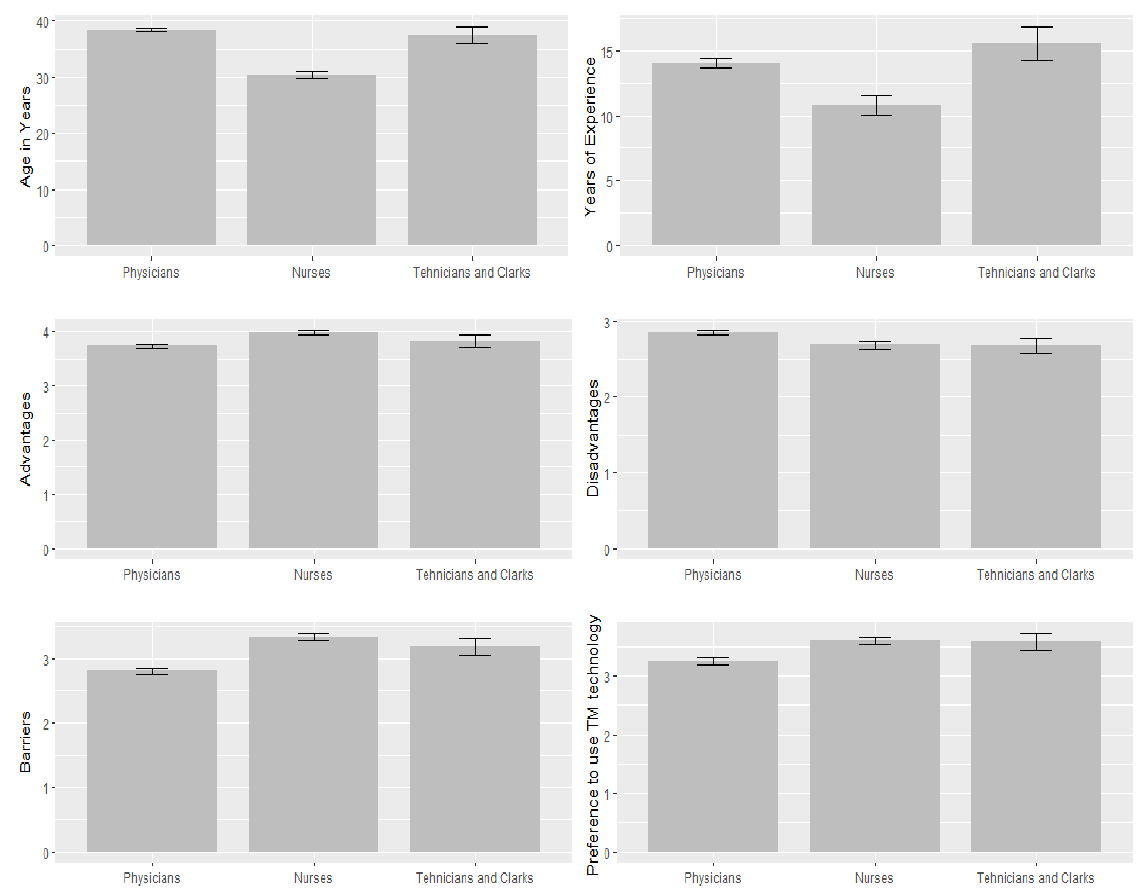
Figure 4. Comparing PTIDB domains according to the healthcare professional speciality.